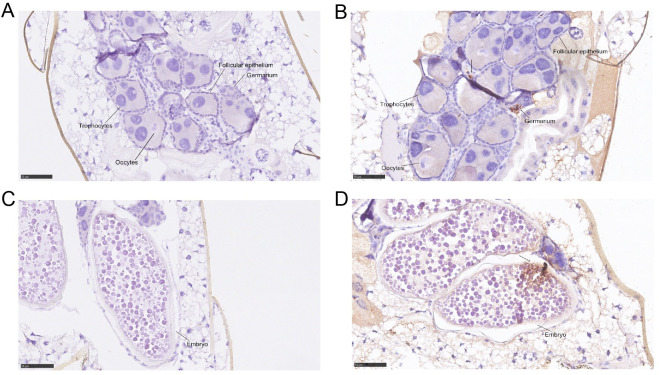
ZIKV infection in the ovaries (14 dpi).Viral antigens were detected using IHC, which revealed viral proteins in the germarium (B) and embryo (D) at 14 dpi. Positive staining for ZIKV is displayed as obvious brownish-red staining caused by the oxidation of DAB by HRP within the organs of the mosquitoes. Tissues that were dissected from uninfected mosquitoes were used as controls (A, C).